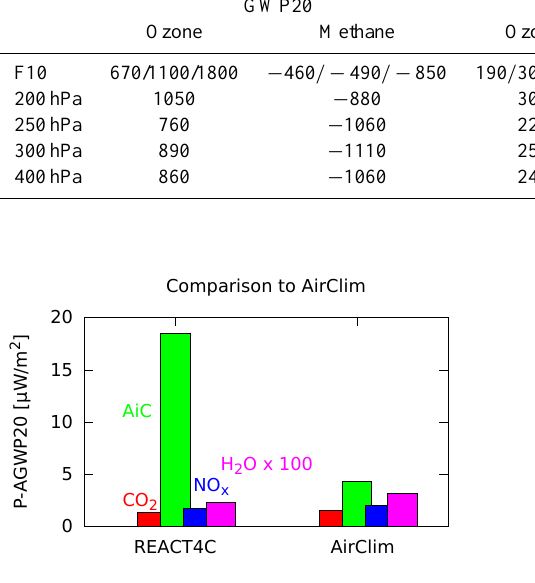
Fig. 13. Comparison of the pulse absolute global warming poten- tial (P-AGWP20) in [ µ W/m 2 ] for emissions of CO 2 (red), con- trail cirrus (green), NO x (blue) and H 2 O (magenta). Note that the H 2 O values are multiplied by 100 for presentational purposes. The emissions from the minimum economic cost one-day transatlantic air traffic, which are calculated with SAAM, are multiplied with the climate cost functions (REACT4C, left) and taken as annual mean emissions for the climate–chemistry response model AirClim